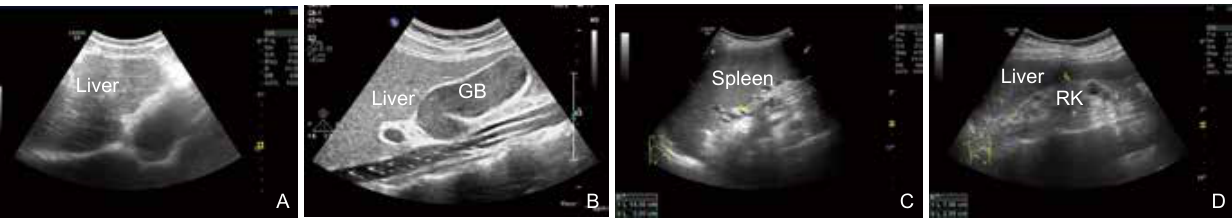
chronic damage change. GB, Gallbladder; RK, Right